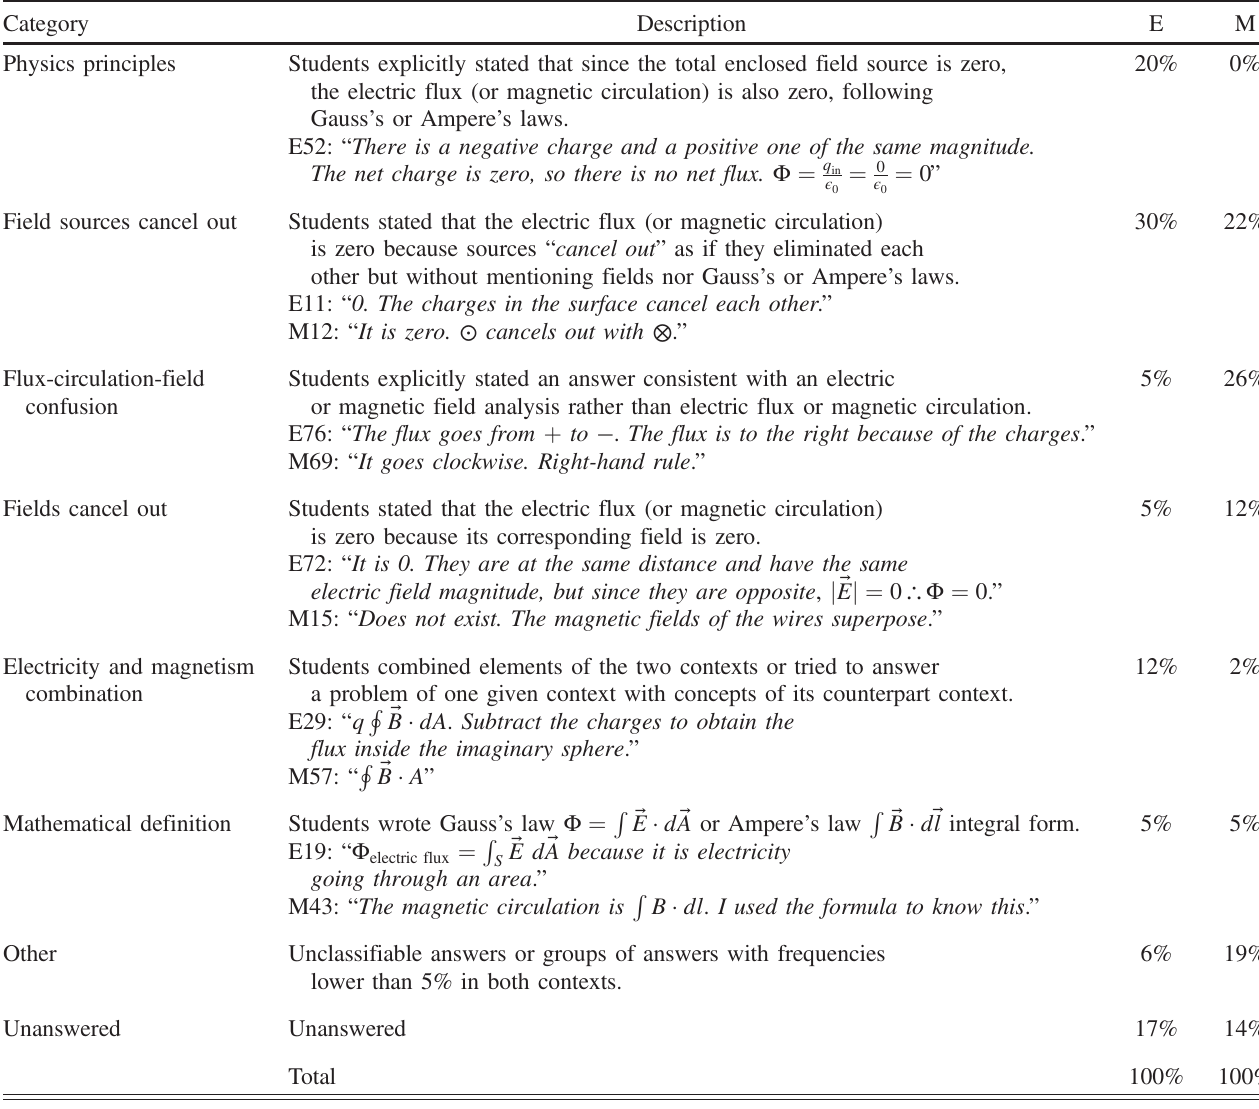
TABLE I. Results of the six main categories derived from the data analysis. Each category includes an example. Category Students explicitly stated that since the total enclosed field source is zero, the electric flux (or magnetic circulation) is also zero, following Gauss ’ s or Ampere ’ s